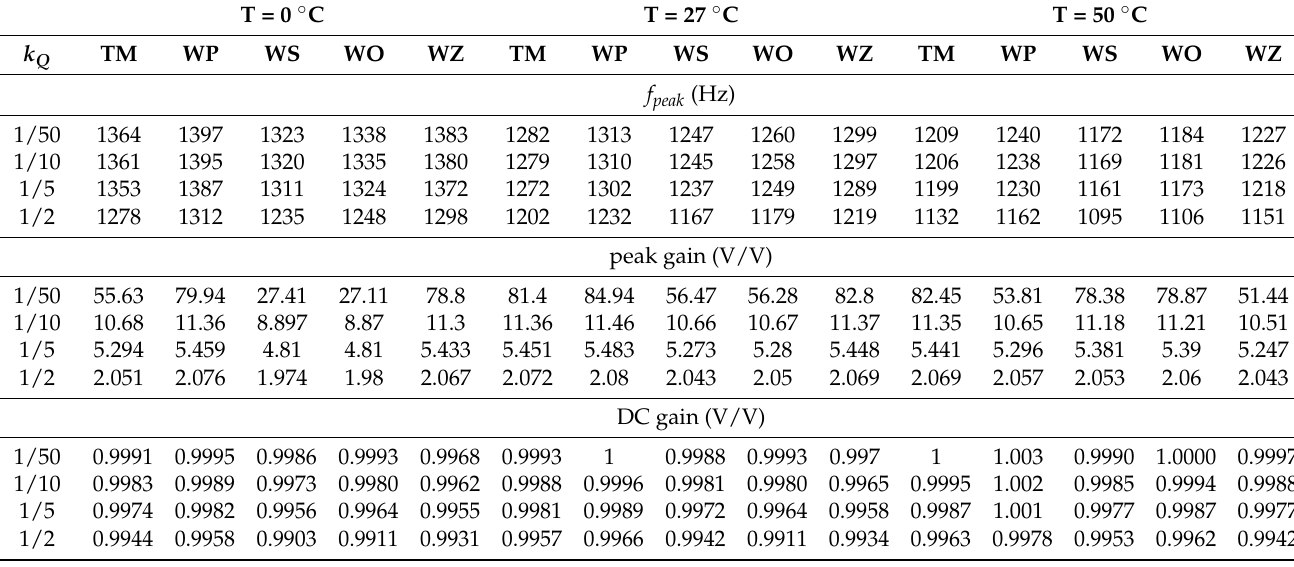
Table A3. Corner simulation results for the middle-band filter at V DD of 0.525